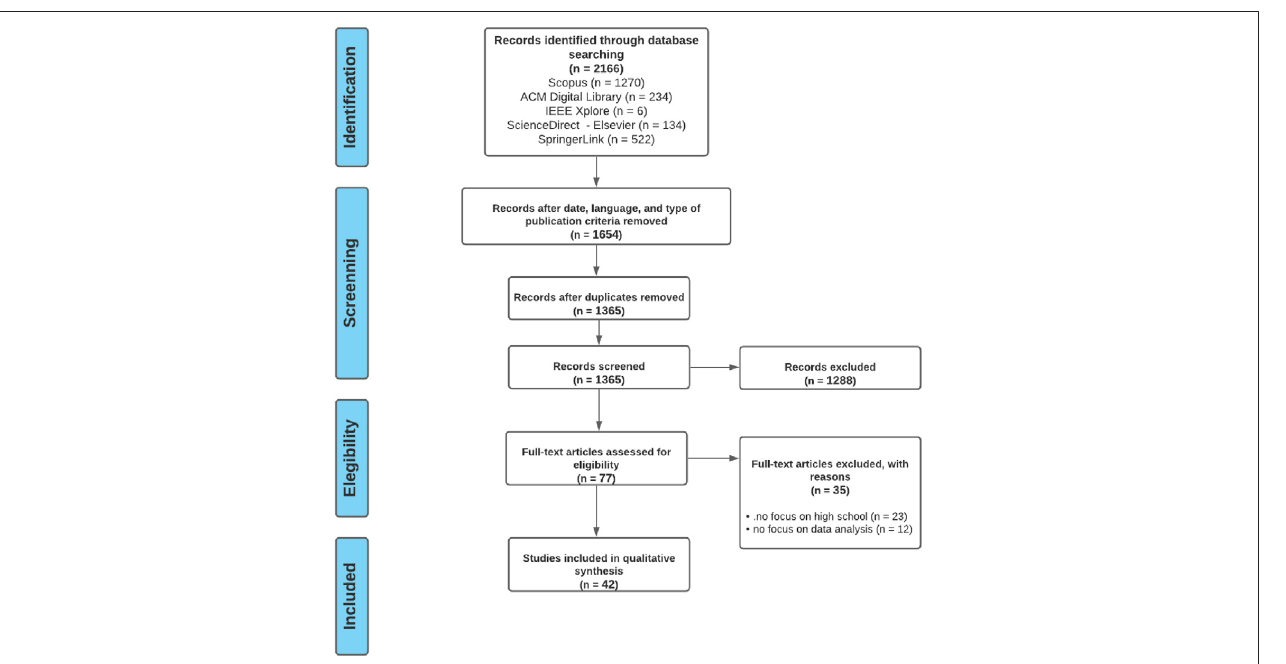
FIGURE 1 | PRISMA Flowchart. The PRISMA fl ow diagram for the systematic review detailing the database searches, the number of abstracts screened, and the full texts retrieved.